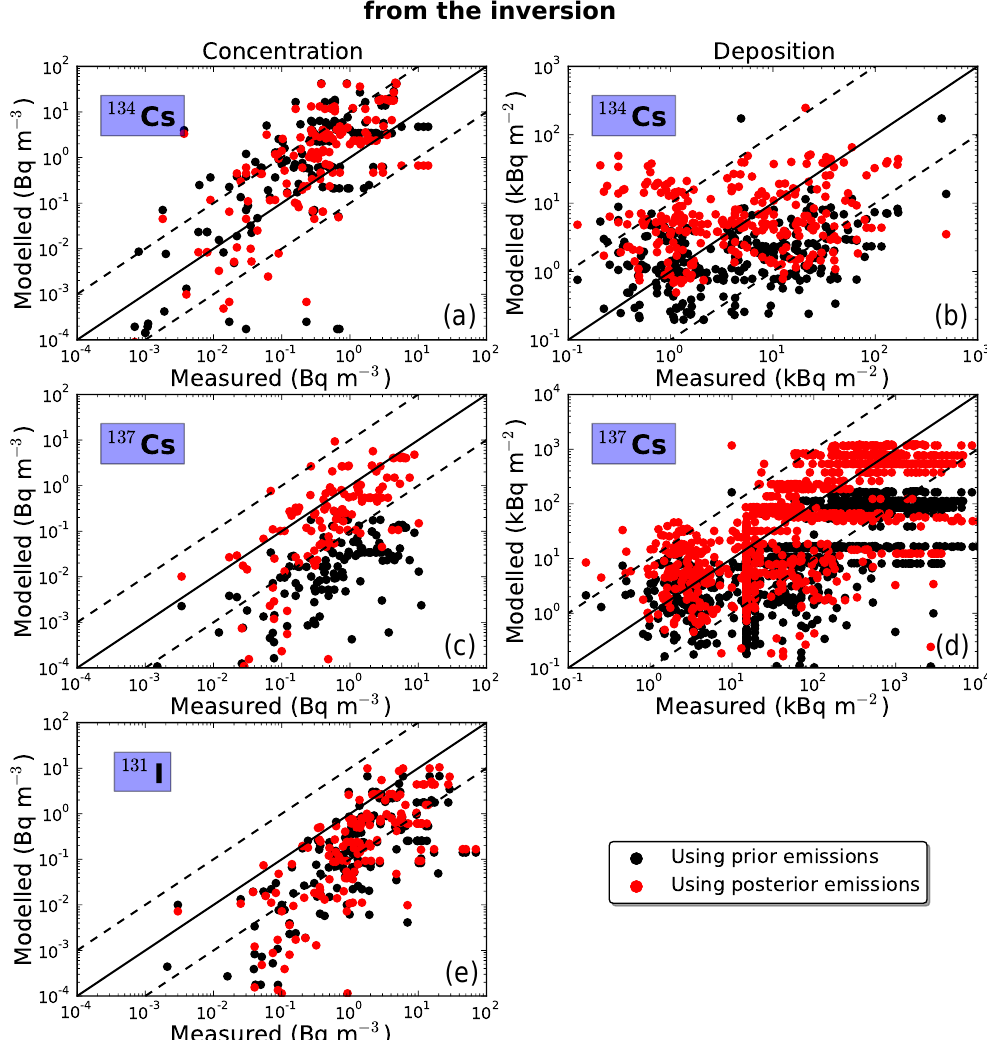
Figure 7. Left column: comparison of modeled concentrations with observations excluded from the inversions for 134 Cs ( N 134 = 318), 137 Cs ( N = 232) and 131 I ( N = 318). Right column: comparison of modeled deposition densities with observations excluded from the 137 131 inversions for 134 Cs ( N 134 = 273) and 137 Cs ( N 137 =